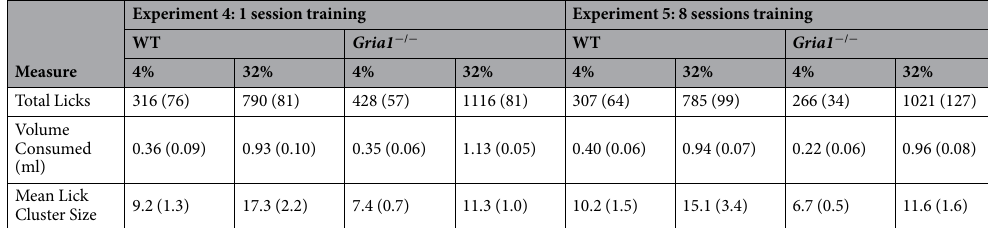
Table 4. Flavour conditioning training data for Experiments 4 and 5. Mean (SEM) total licks, volume consumed, and lick cluster size for WT and Gria1 − / − mice for 4% and 32% sucrose solutions during training for Experiments 4 and